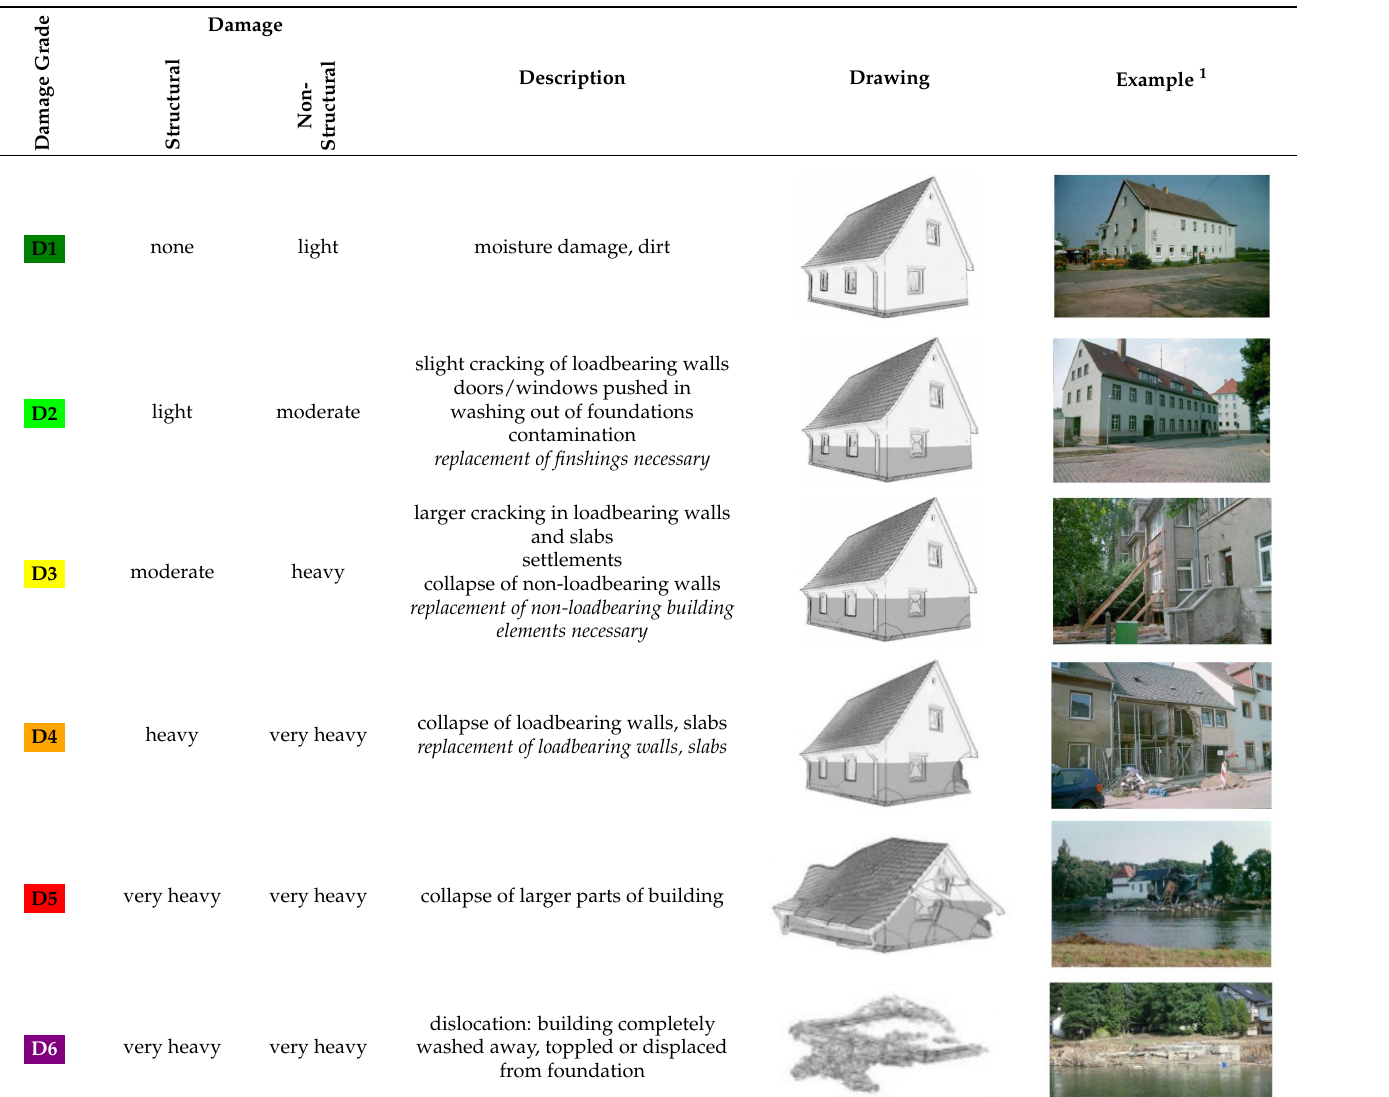
Table 3. Extended flood damage scale with examples of the 2002 flood in Saxony [24] and the flood of 2021